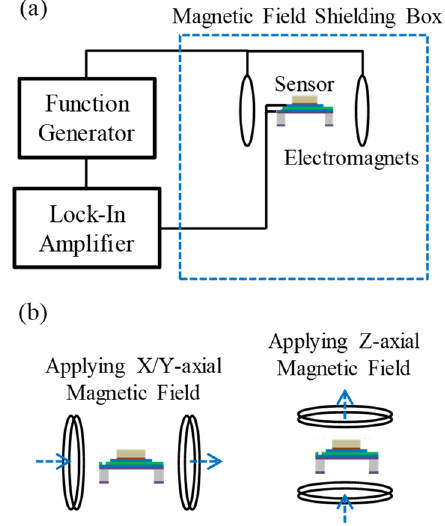
Figure 7. The illustration of the testing setup: ( a ) testing setup for three-axial AC magnetic field sensing. The arrangement of electromagnets for applying ( b ) X-/Y-axial and ( c ) Z-axial magnetic fields with a frequency of 7.5 kHz to the sensor. Note: two elements (element A and element B) are used together as one sensor and were thus simultaneously tested under the different arrangements of electromagnets when applying X-/Y- and Z-axial magnetic fields.